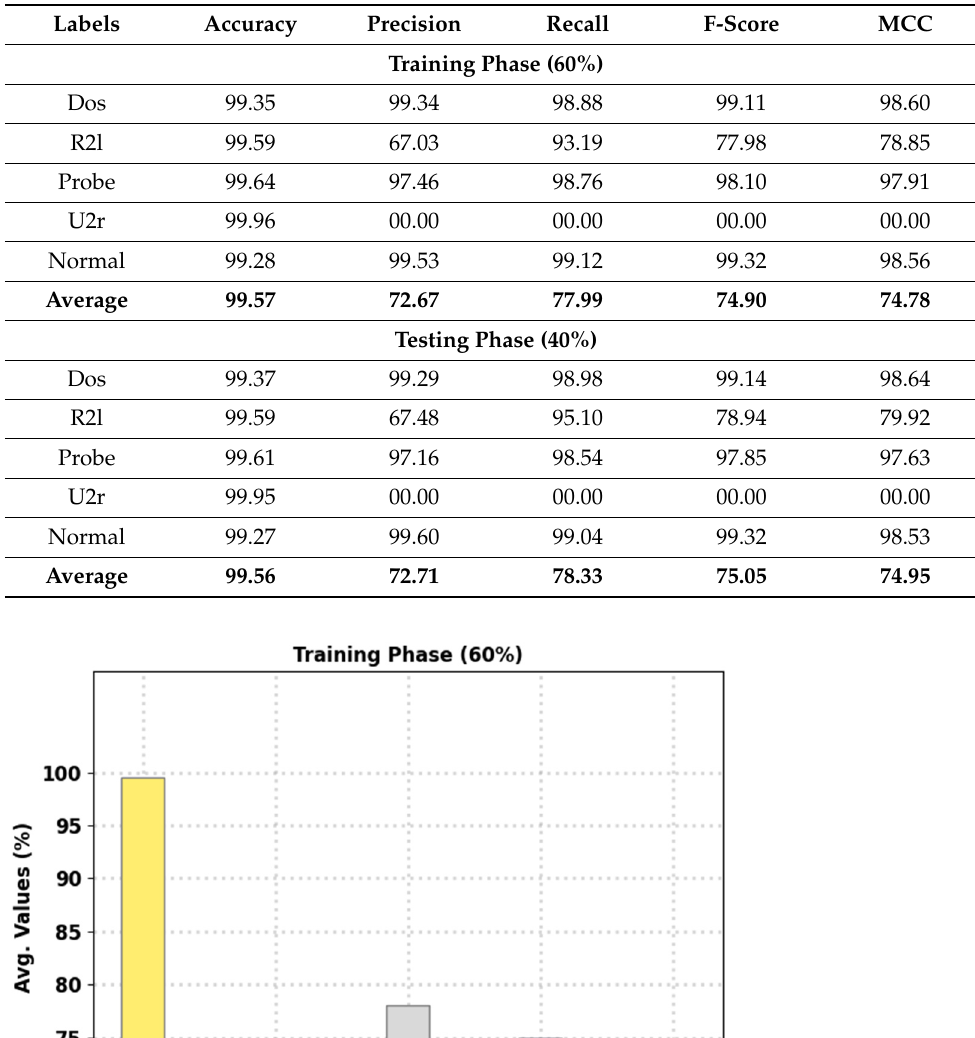
Table 2. Result analysis of FSHDBN-CID algorithm with distinct class labels under 60:40 of TR and TS datasets.